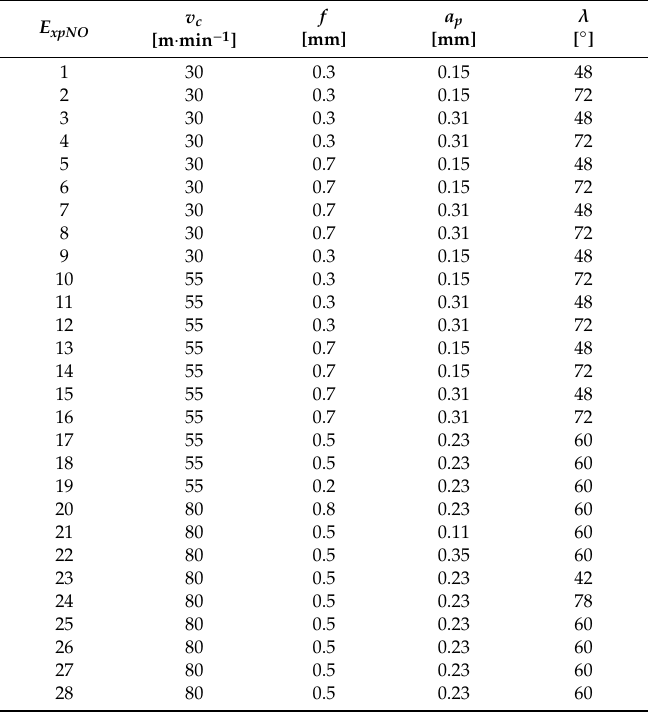
Table 5. Discrete cutting parameters according to individual E xpNO